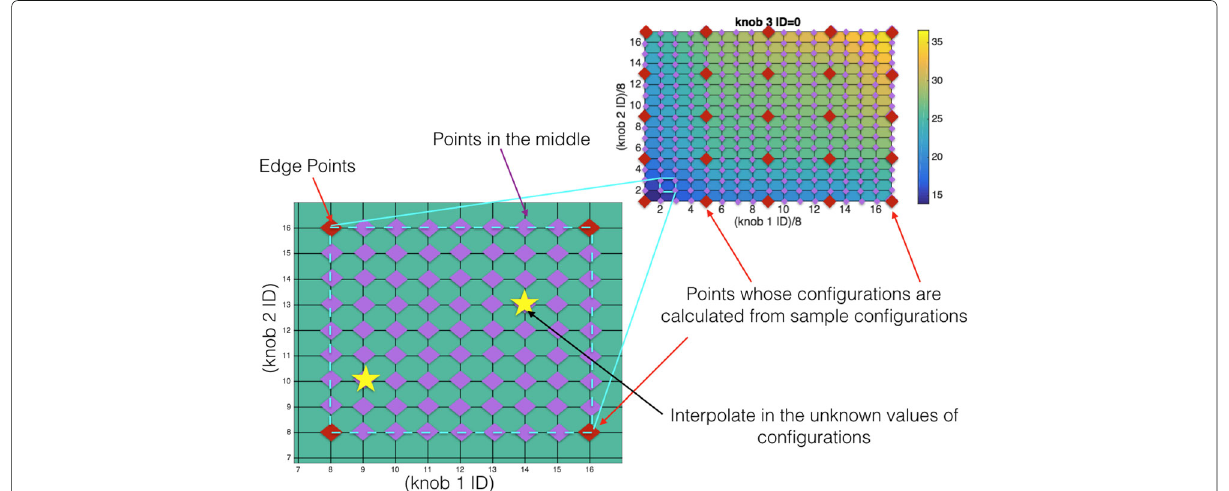
Fig. 8 The interpolation method is applied to obtain information of the configurations with known RF impairments from the configurations with unknown RF impairments